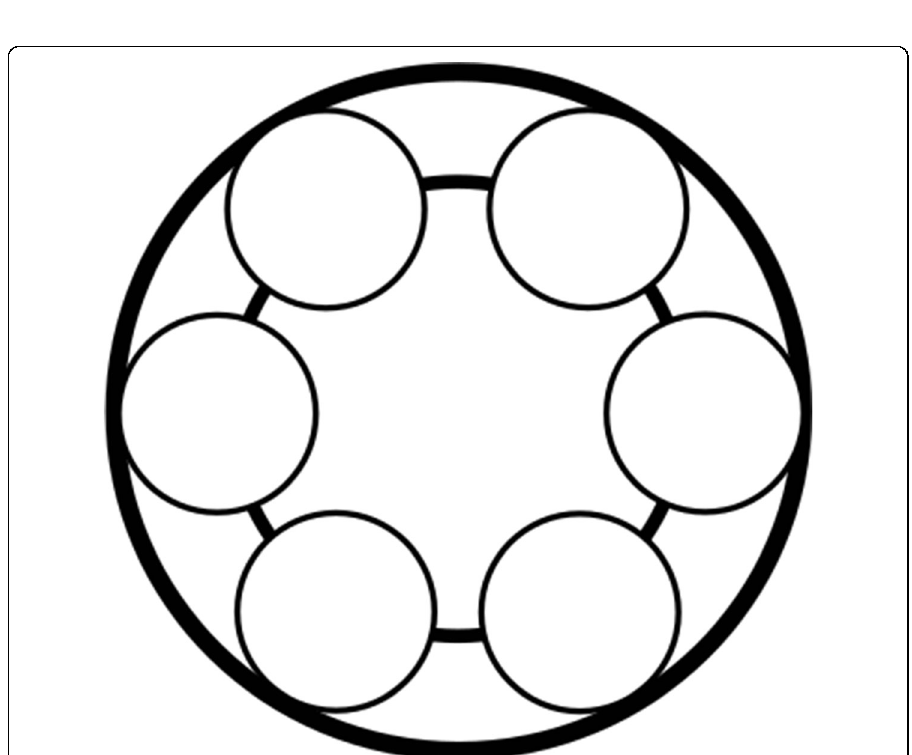
Fig. 18 Legend: The smaller circles indicate associates ’ languages, the circle they are overlapping is English as the shared space they construct and that connects